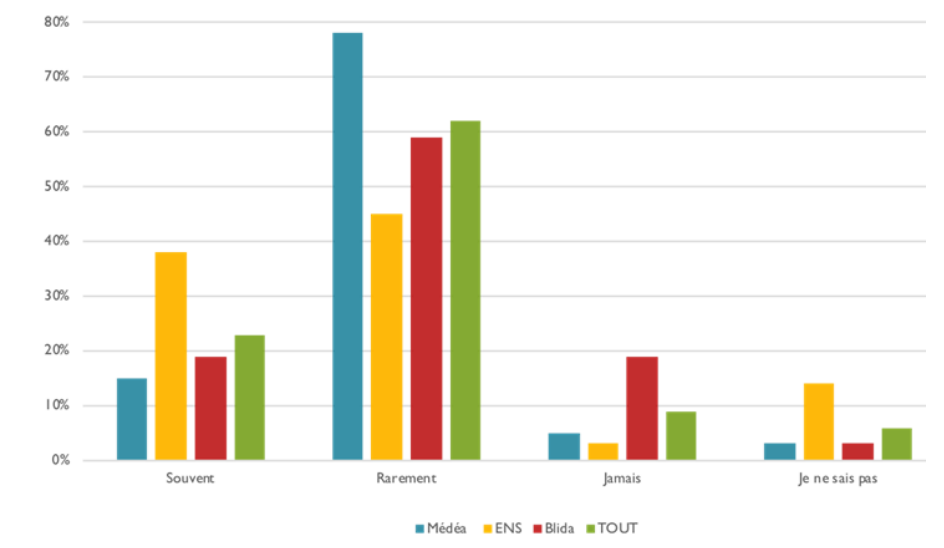
Fig. 2-a. La prise en compte du concept de modèle.